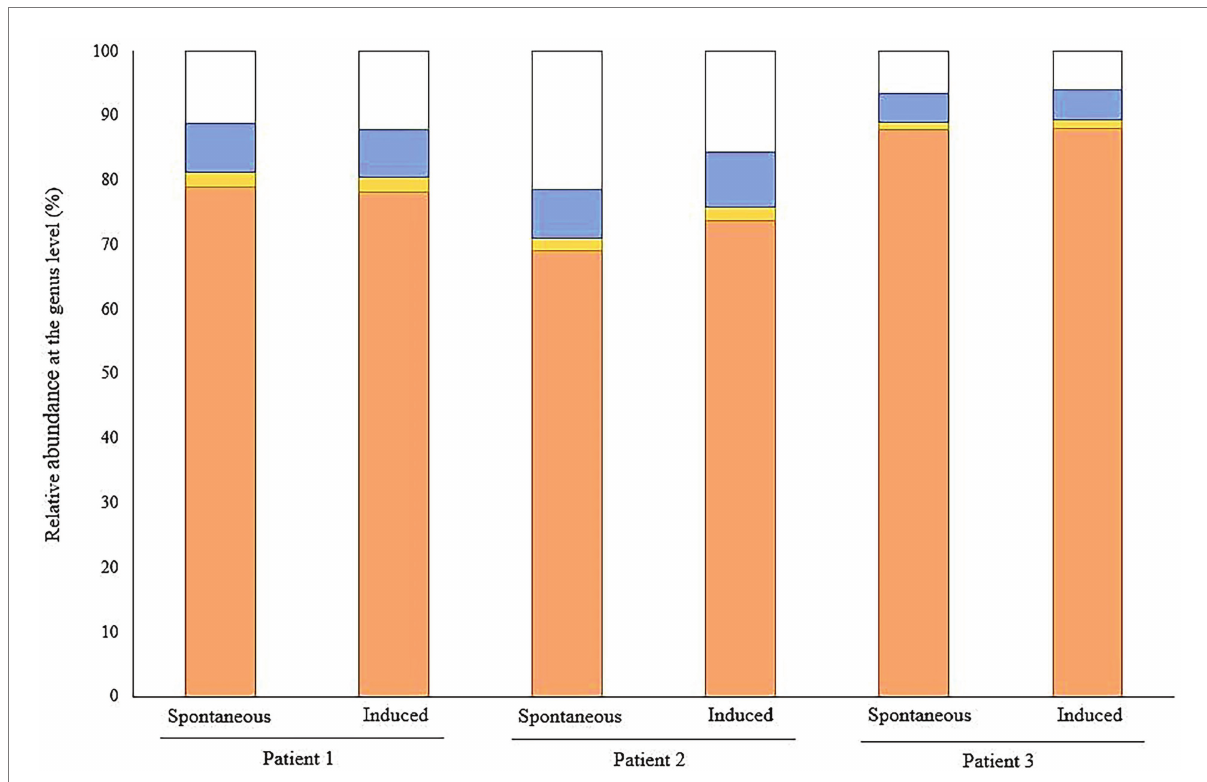
FIGURE 2 Relative protein abundance according to their human, fungal or bacterial origin. The stacked bar graphs show the relative abundance (%) that corresponds to the normalized TSM signals at the genus level from the triplicates of each sample for human signal (orange), fungal taxa (yellow), bacterial taxa (blue) and the non-attributed signals at the taxonomic level of genus